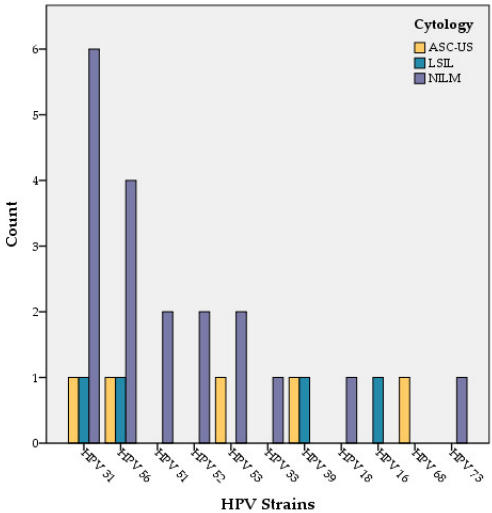
Figure 2. HPV distribution regarding cytology findings.